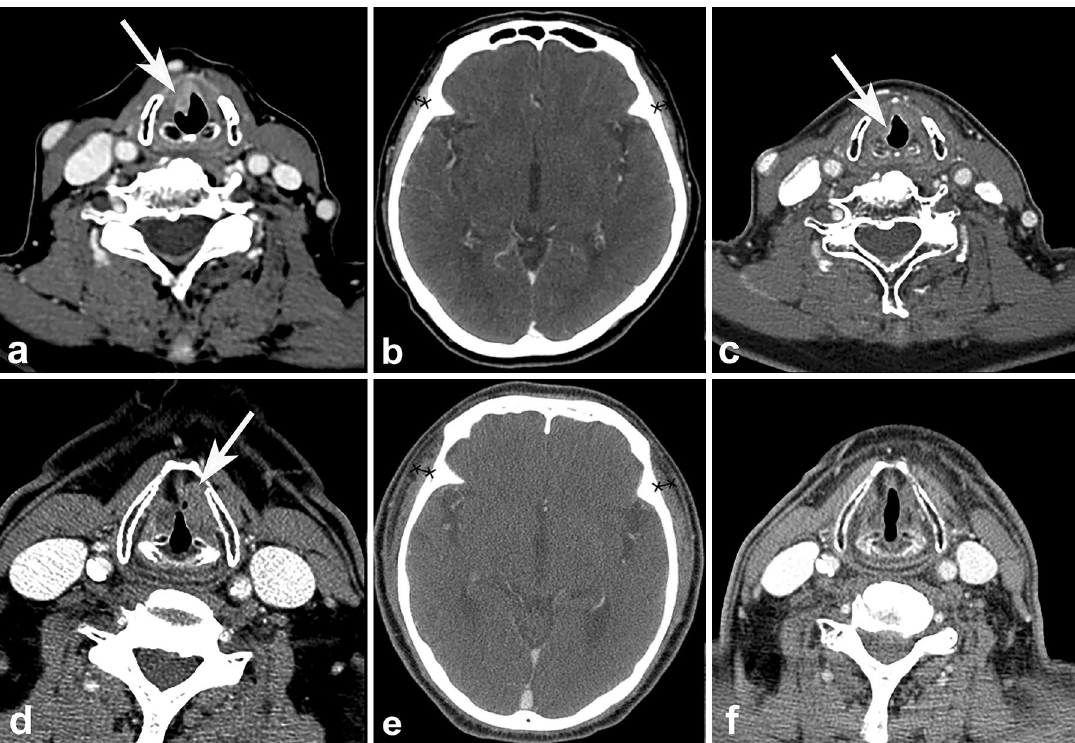
Figure 5. Representative cases of temporalis muscle thickness (TMT) on CT, and its association with progression-free survival. A 72-year-old female was diagnosed with glottic cancer (cT2N0M0) ( a , arrow). On the axial CT scan, the averaged TMT was measured as 4.56 mm ( b ), which was less than the threshold of 6.24 mm. After 6 months after diagnosis, she developed local tumor recurrence in the anterior glottis ( c , arrow). Another 74-year-old female who was diagnosed with glottic cancer (cT2N0M0) ( d , arrow) had baseline TMT of 6.56 mm ( e ), which was larger than the threshold of 6.24 mm. During the follow-up period of 42 months, the patient did not develop tumor recurrence ( f